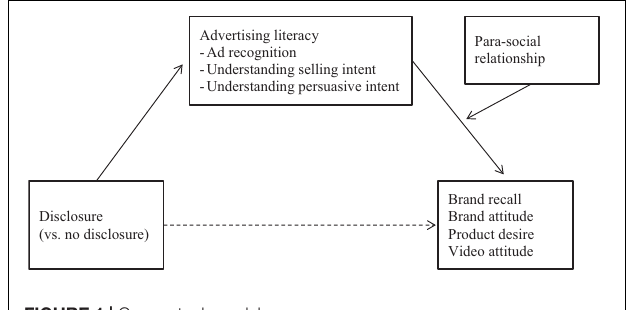
FIGURE 1 | Conceptual